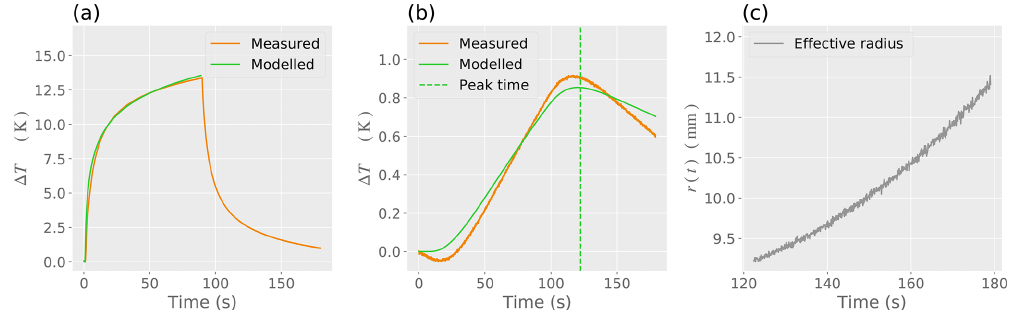
Figure 6. Example signal processing for peat showing (a) the measured and modelled SP heating curves; (b) the measured and modelled DP heating curves along with the detected peak time; and (c) the detected change in effective radius r(t) from the signal processing. The effective radius r(t) as obtained from signal processing compensates for model error, experimental error, and physical changes in the spacing of the heater needles. Table 5. Comparisons for peat example. Quantity and units Signal processing Heating